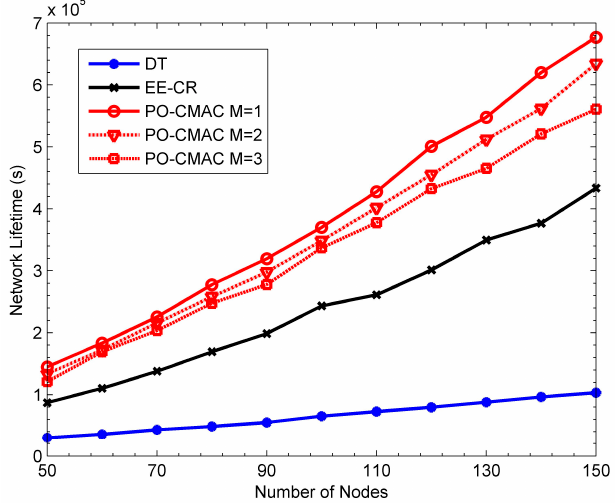
Figure 9. Network lifetime with varying N at uniform traffic load.